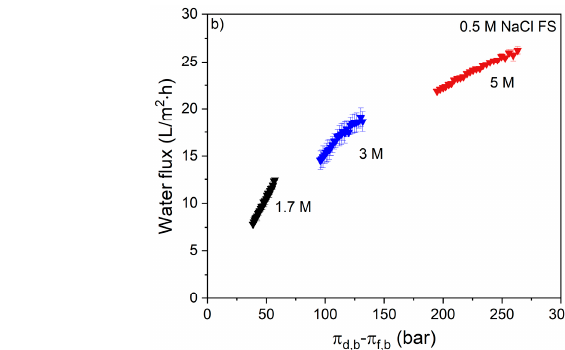
Figure 5. The effect of osmotic pressure difference with 0.5 M NaCl in the FS on ( a ) the water flux as a function of permeate volume and ( b ) the water flux as a function of effective osmotic pressure (FS: 0.5 M NaCl). Average values represent two runs.